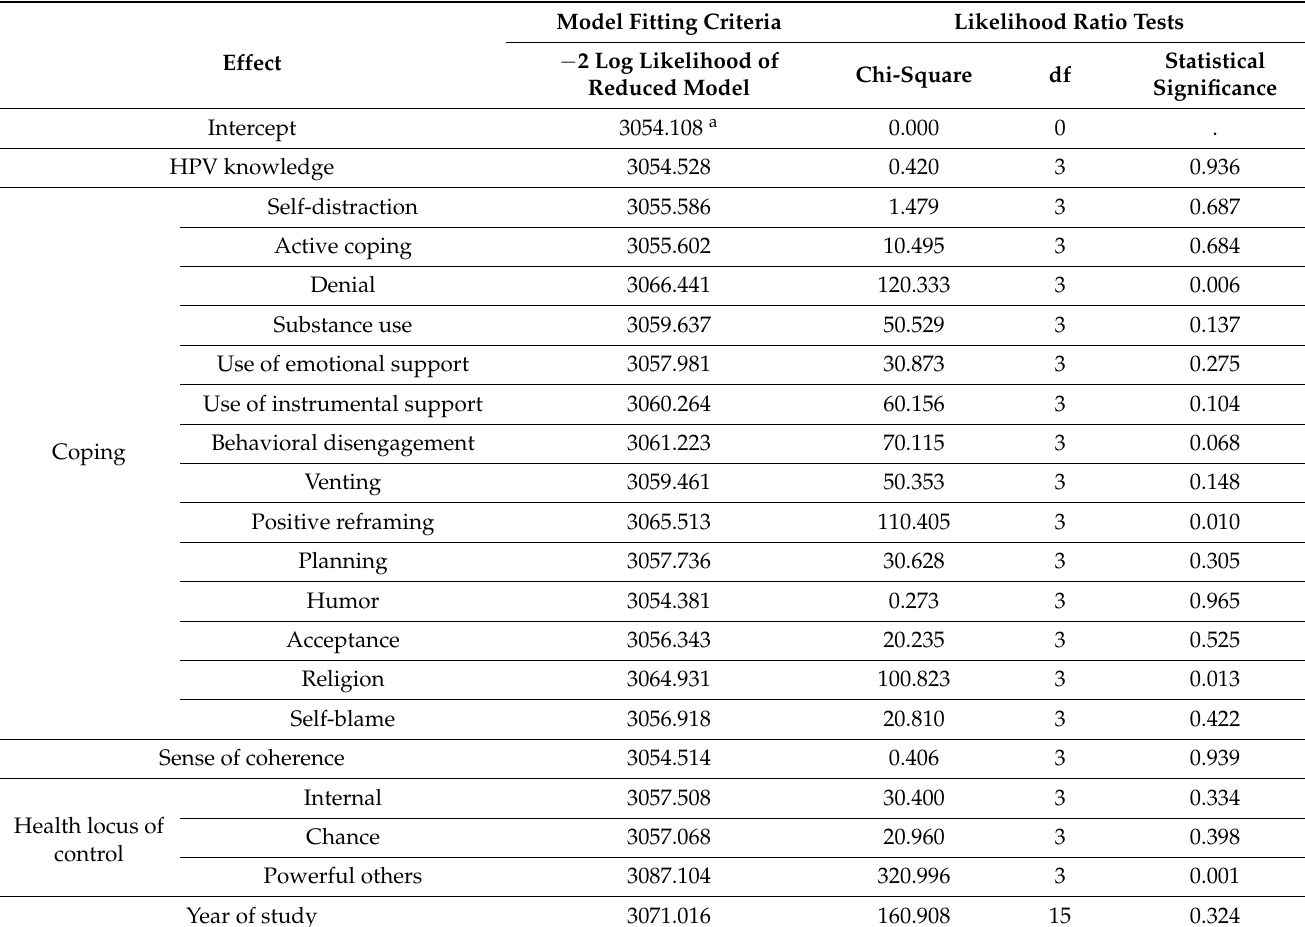
Table 4. Predictors of the vaccination